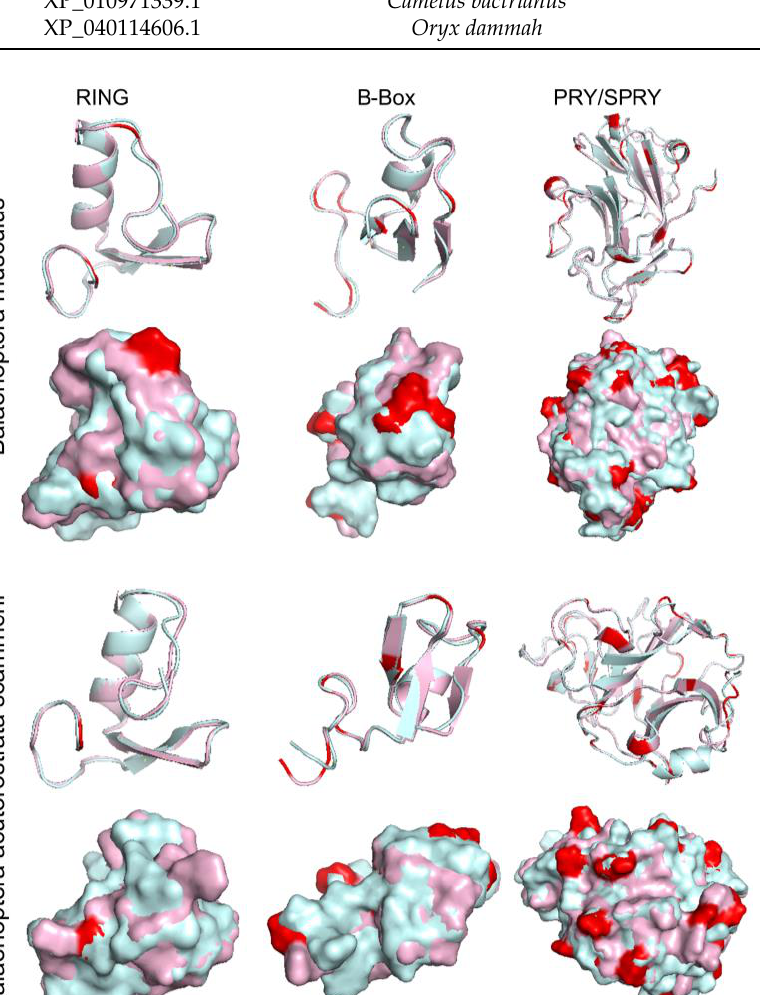
Figure 4. Comparison of TRIM21 derived from swine and eight other species. The conserved residue is labeled in white. Red indicates different amino acids.